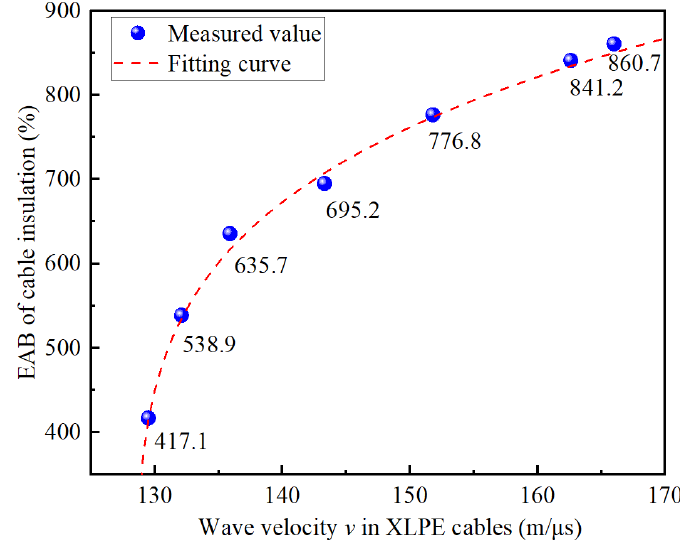
Figure 12. Relation curve of the EAB of the cable insulation versus wave velocity in XLPE cables.